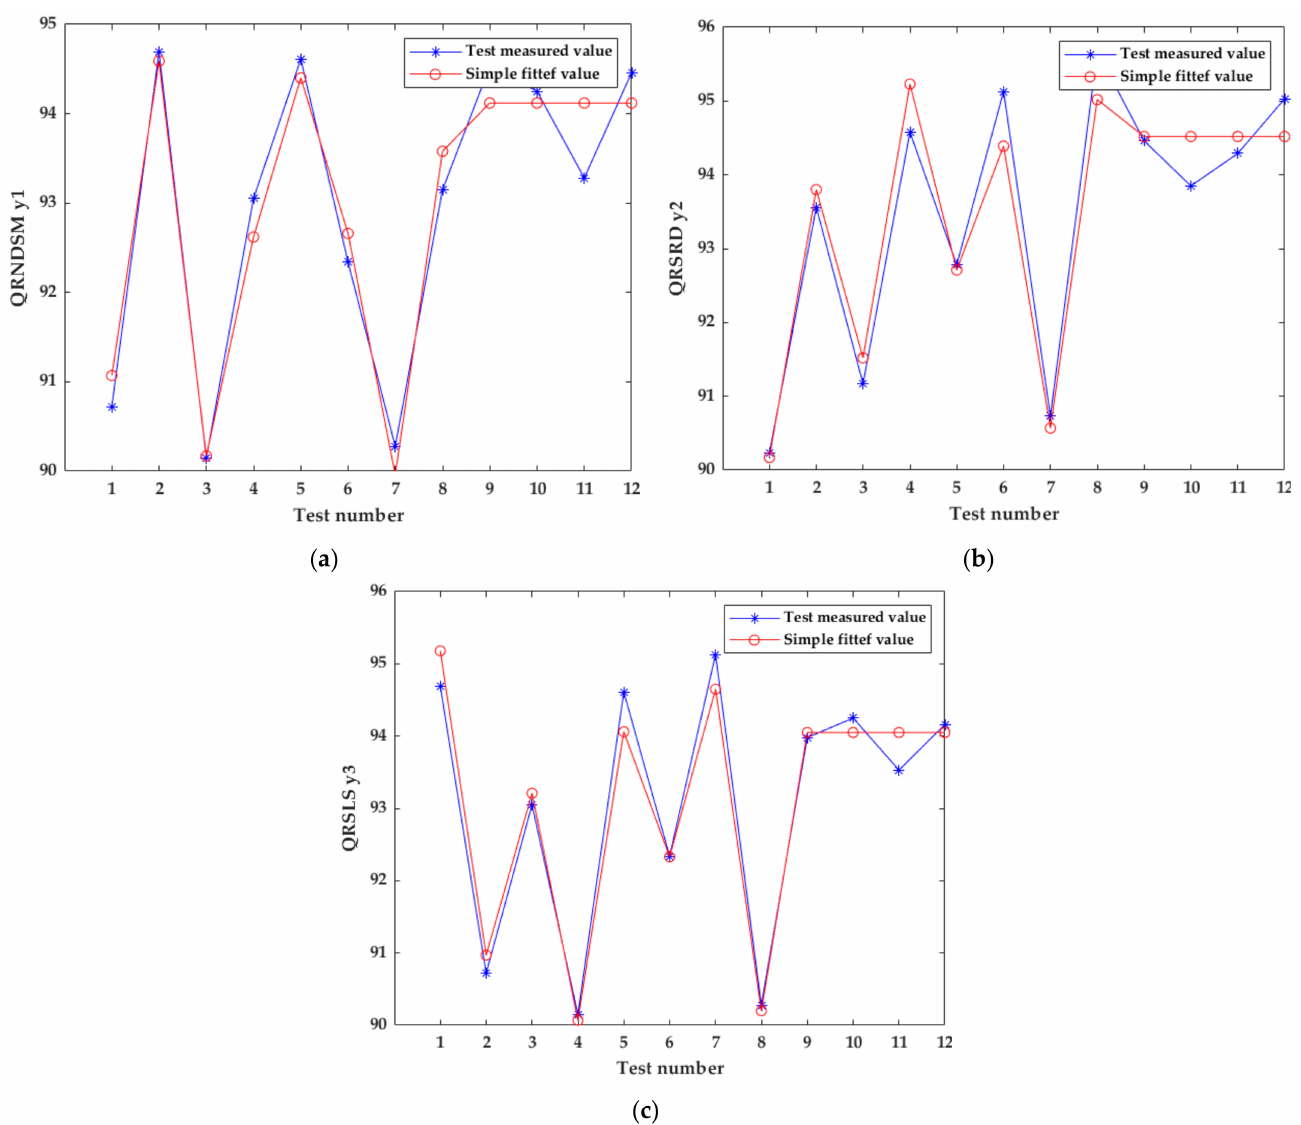
Figure 12. The comparison between the curve of the test value and the curve of the fitted value. ( a ) QRNDSM, ( b ) QRSRD, ( c )